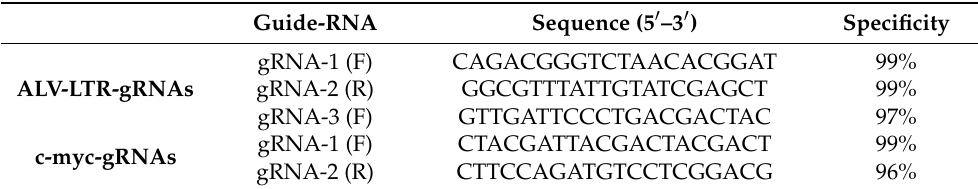
Table 2. ALV-LTR and c-Myc guide-RNA sequence. Guide-RNA Sequence (5 (cid:48) –3 (cid:48) )